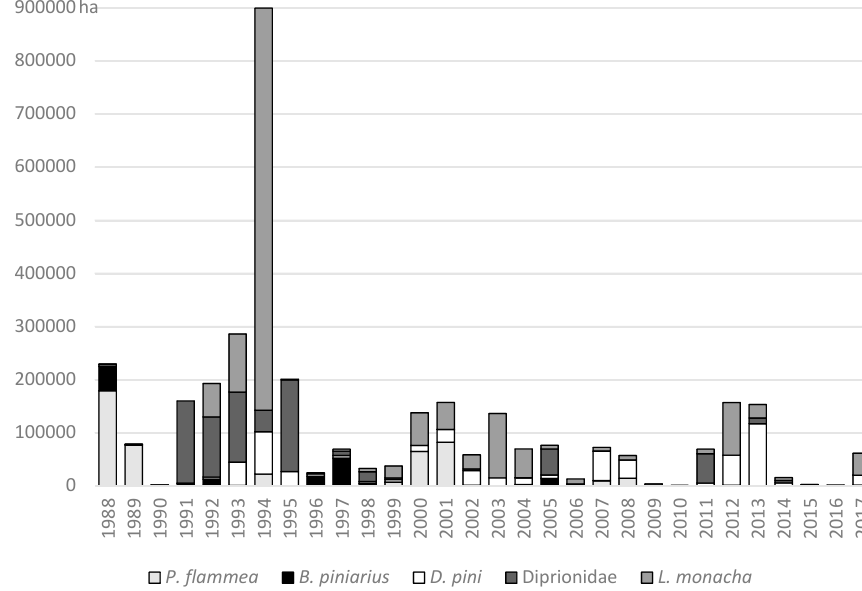
Figure 1. Area of aerial chemical insecticide treatments against pine defoliators in Poland between 1988 and 2017 ([35], modified).